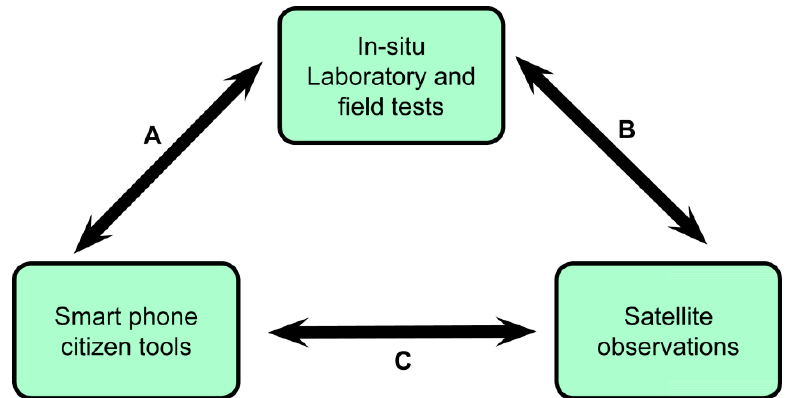
Figure 2. Relationships between citizen science tools, in situ measurements with standard equipment, and satellite observations. Citclops/EyeOnWater citizen tools are tested and validated by direct relation to standard in situ- and laboratory measurements (relation A); Which are commonly related to satellite data in big validation campaigns (relation B); By compliance with satellite products, citizen science tools are directly related to satellite observations (relation C), and indirectly via relations A and B.